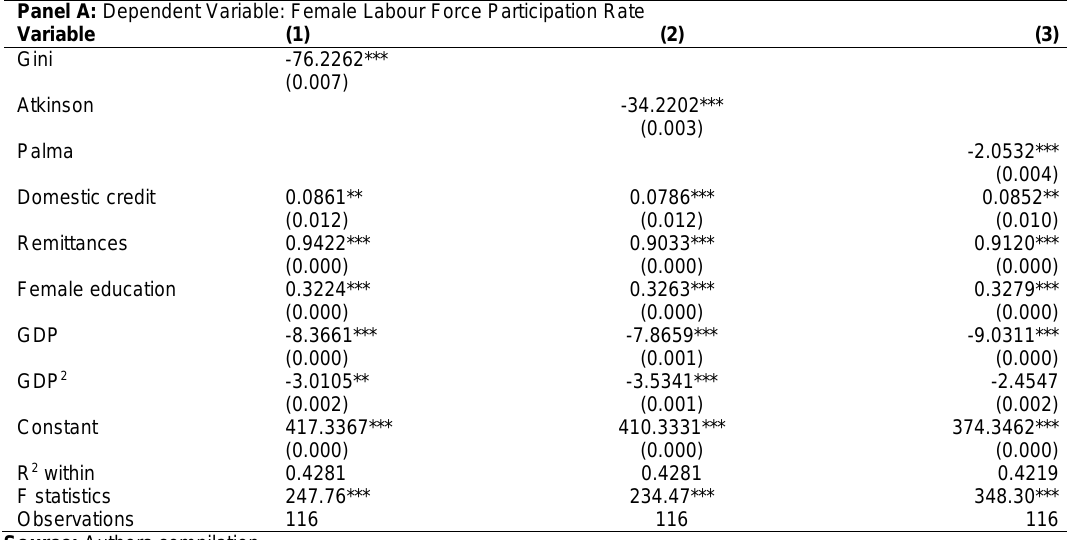
Table 3. Instrumental Variable Fixed Effects Results